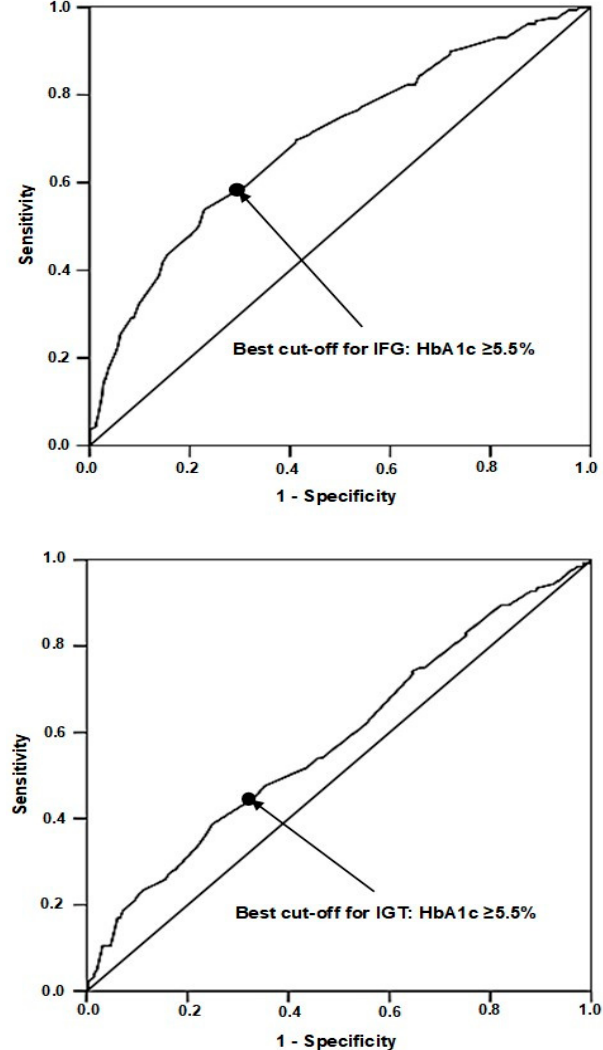
Figure 1. Area under curve of HbA1c with respect to IFG ( top panel) and IGT ( bottom panel). The characteristics of the sample divided by the two HbA1c cut-offs are summarized in Table 1. Table 1. Anthropometric, clinical, metabolic and beta-cell function variables according the two cut- offs of HbA1c.